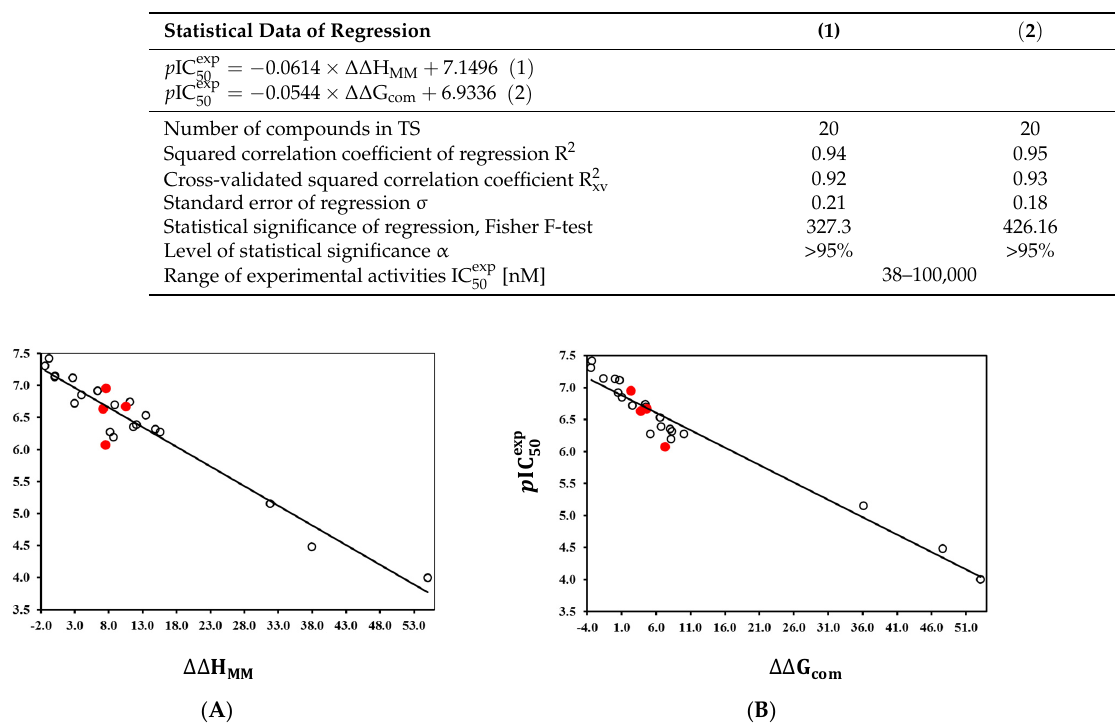
Table 3. Regression analysis of computed binding affinities ∆∆ G com , its enthalpic component ∆∆ H MM , and experimental half-maximal inhibitory concentrations p IC towards the Pf ENR [21,23,25,27].